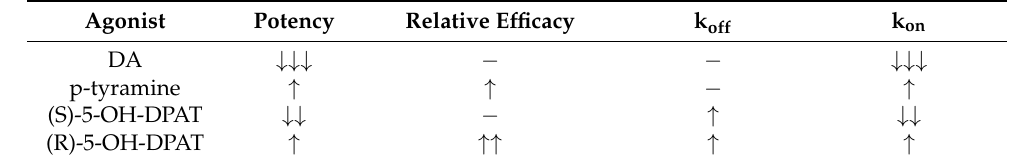
Table 2. Relative changes in agonist potencies, forward (k on ) and reverse (k off ) rate constants and calculated kinetic potencies at the S193 5.42 A mutant, as compared to WT D 2 R. Agonist Potency Relative Efficacy k off k on DA ↓↓↓ − − ↓↓↓ p-tyramine ↑ ↑ − ↑ (S)-5-OH-DPAT ↓↓ − ↑ ↓↓